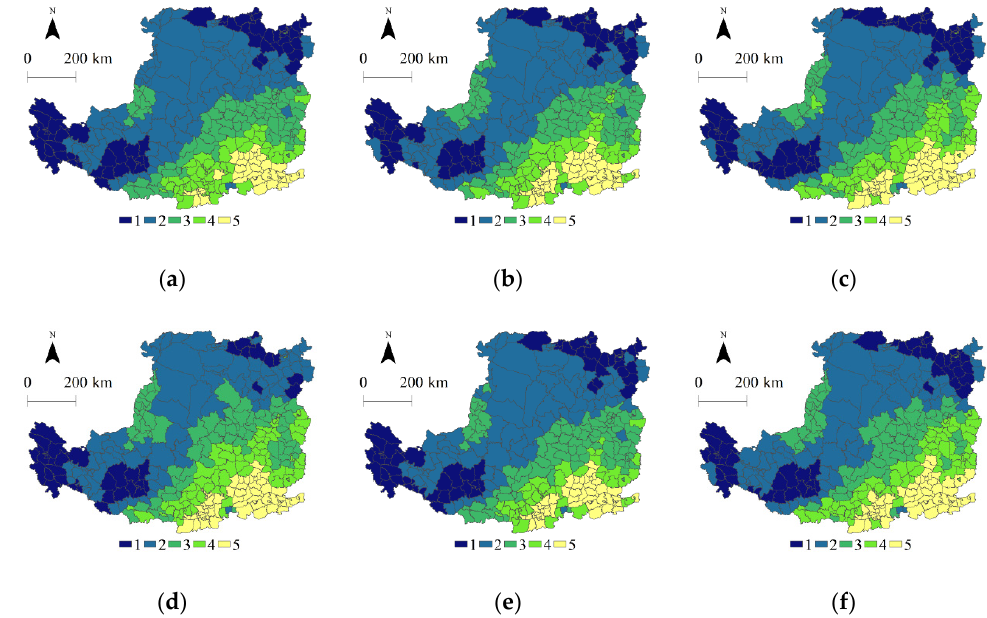
Figure 8. ( a ) Average temperature in 2000. ( b ) Average temperature in 2010. ( c ) Average tempera ‐ ture in 2020. ( d ) Average lagged temperature in 2000. ( e ) Average lagged temperature in 2010. ( f ) Average lagged temperature in